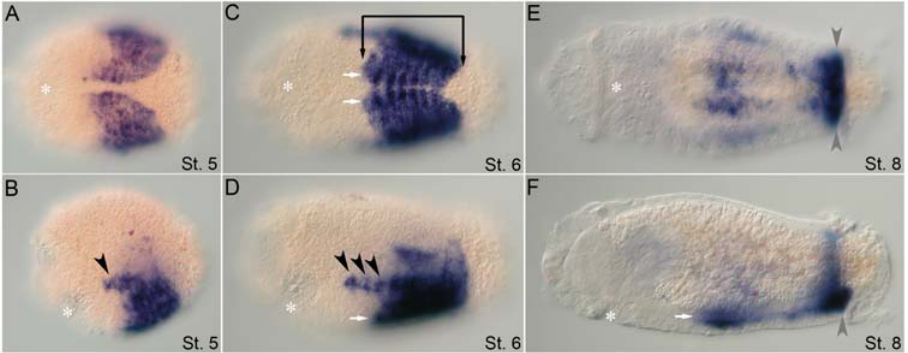
Figure 8. Larval expression of CapI-lox5 . Anterior is to the left for all panels. Stages are indicated at bottom right of each panel. (A), (C), and (E) show ventral views; (B), (D), and (F), lateral views with ventral down. Mouth is marked by an asterisk. (A, B) Expression in the ventrolateral ectoderm extends from T4 to the posterior border of the belly plates at early stage 5. Lateral bands extend rostrally from the broad expression domain (black arrowhead). (C, D) Expression is in the VNC (white arrows), ventrolateral ectoderm, and in segmentally iterated lateral patches (black arrowheads). (E, F) At stage 8, CapI-lox5 expression becomes most prominent in the VNC (white arrows) and posterior growth zone (gray arrowheads).